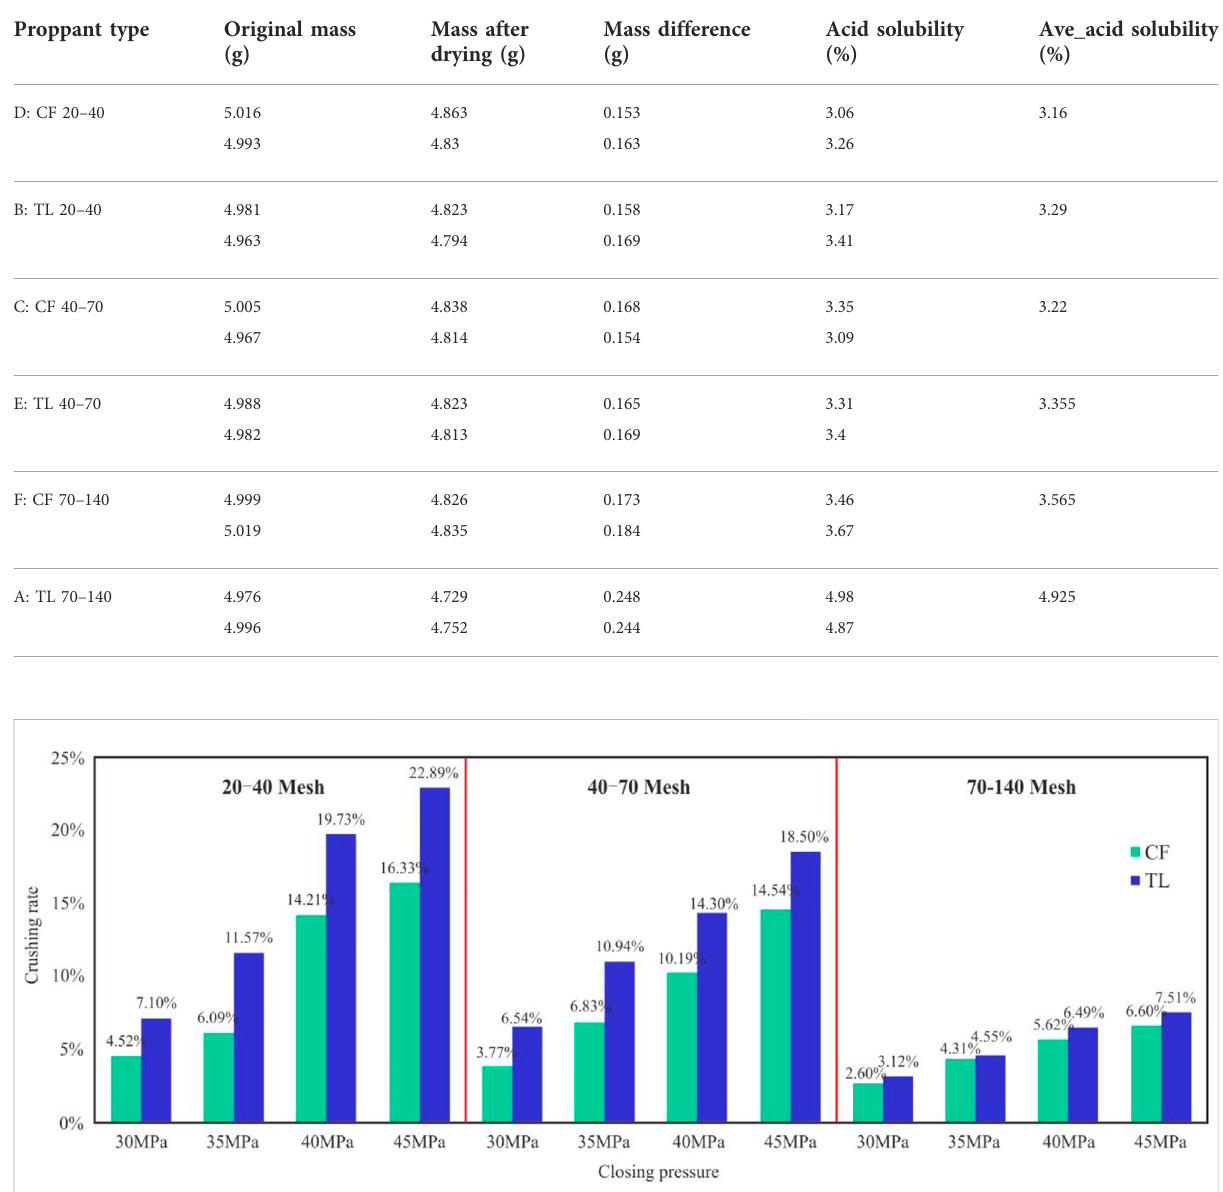
TABLE 2 Measurement of acid solubility of different proppants.